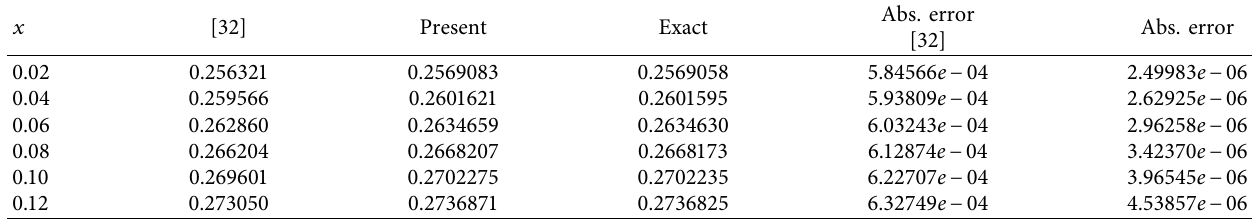
Table 4: Comparison of approximate solutions and absolute errors of Example 2 with [32] at T � 0 . 02 for h � 0 . 0001, v � 1, and α � 0 . 8. x